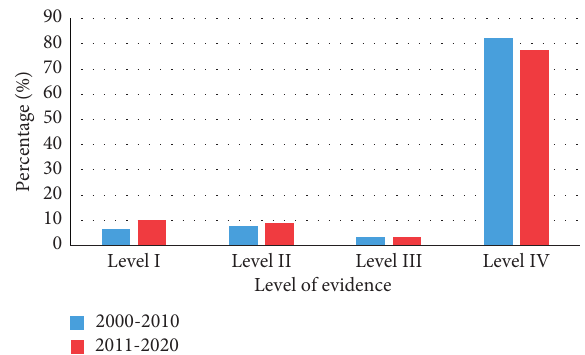
Figure 3: The percentage of Saudi dental published studies ranked by Oxford level of evidence scale in the last two decades.